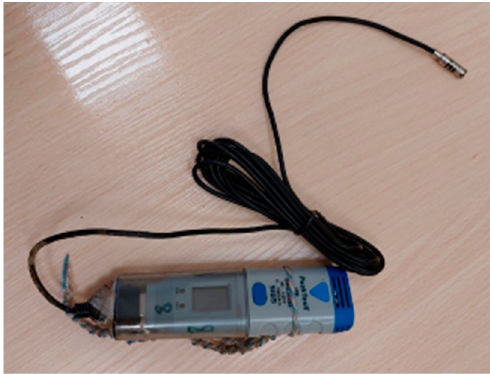
Figure 2. Data loggers PeakTech P5185 [27] (the photo was taken by the authors of the paper).